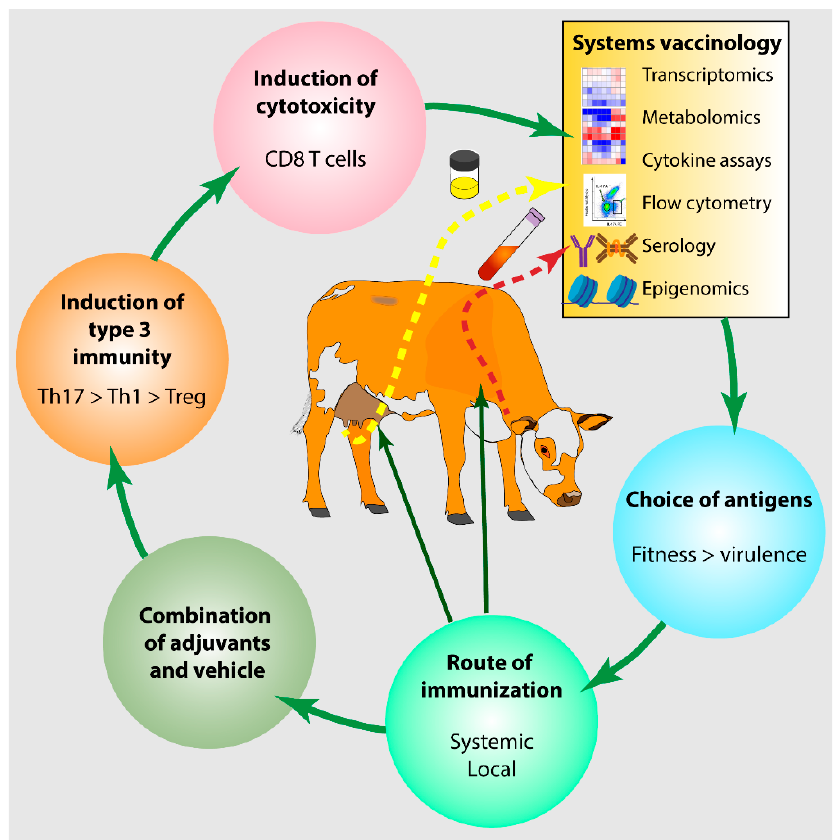
Figure 3. Possible levers to improve the effectiveness of mastitis vaccines. The tentative vaccine incorporates appropriate antigens related to bacterial fitness rather than virulence factors is administered preferably by systemic and local (intramammary) routes with a combination of adjuvants that orient the immune response towards type 3 immunity and the induction of CD8 T cells. The resulting immune response can be monitored with the instruments of systems vaccinology to instruct improvements in another cycle of vaccine development. See text for details.